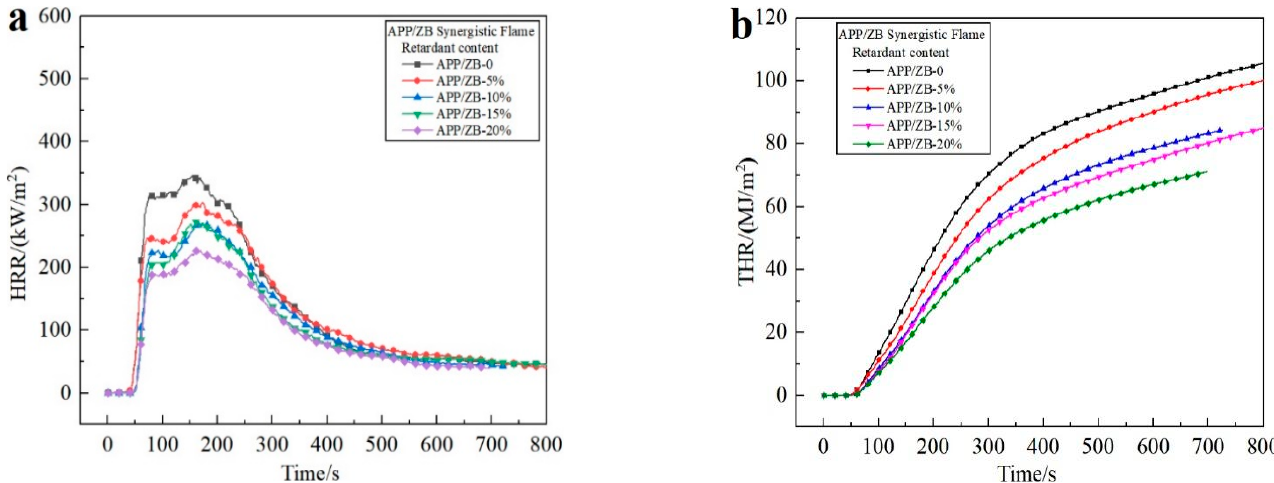
Figure 6. Effect of different APP/ZB content on the heat release rate ( a ) and total heat release Figure 6. E ff ect of di ff erent APP/ZB content on the heat release rate ( a ) and total heat release ( b ) of ( b ) of FWPC.